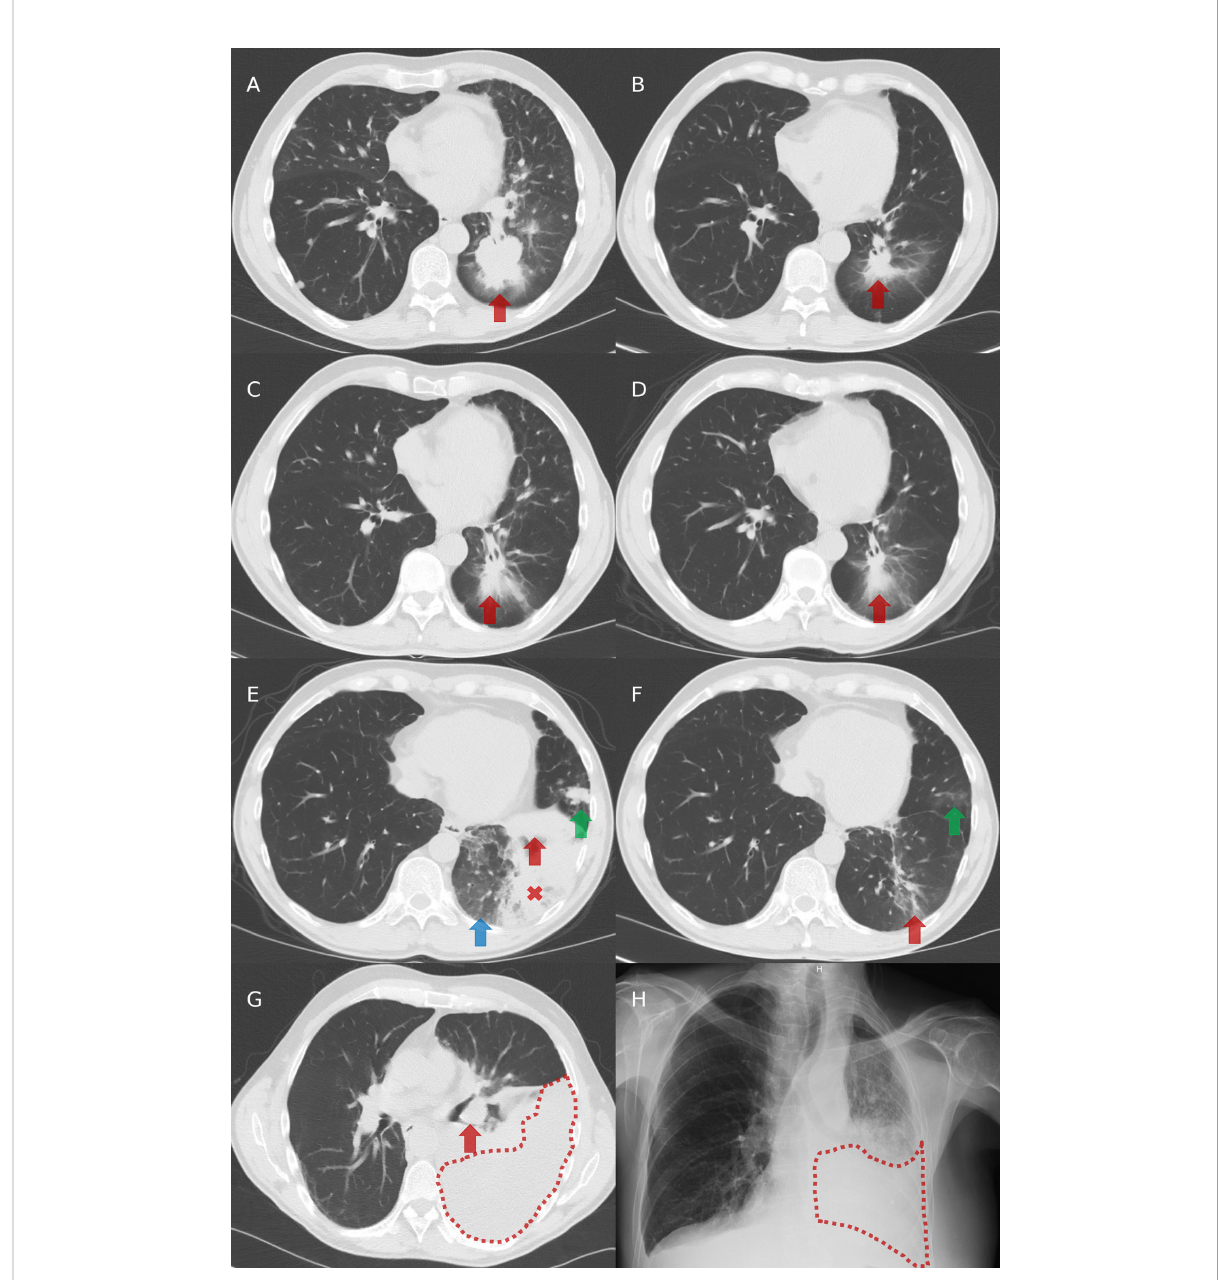
FIGURE 2 Chest imaging evolution. (A) Computed tomography (CT) at diagnosis: presence of a left-lower lobe primary tumor (red arrow). (B) CT after three cycles of cisplatin and pemetrexed in fi rst-line: partial tumor response with decreased size of the primary tumor (red arrow). (C) CT after 7 cycles of pemetrexed in maintenance and then 2.5 months without systemic treatment: tumor progression with increased size of the primary tumor (red arrow). (D) CT after two months on crizotinib in second-line: partial tumor response with decreased size of the primary tumor (red arrow). (E) CT after 5.5 months on crizotinib in second-line: progression of the primary tumor (red arrow), appearance of ground glass opacities (blue arrow), a retro-obstructive condensation in the left lower lobe (red cross), and a nodular lesion in the lingula (green arrow). (F) CT after two months on alectinib in third-line: partial tumor response with decreased size of the left lower lobe primary tumor (red arrow) and of the lingular nodule (green arrow). (G) CT after 15 months on alectinib: tumor progression with increased size of the primary tumor (red arrow) and appearance of a left pleural effusion (area under red dots). (H) Radiography after two months on BRAF/MEK inhibitors in fourth-line: left pleural effusion (area under red